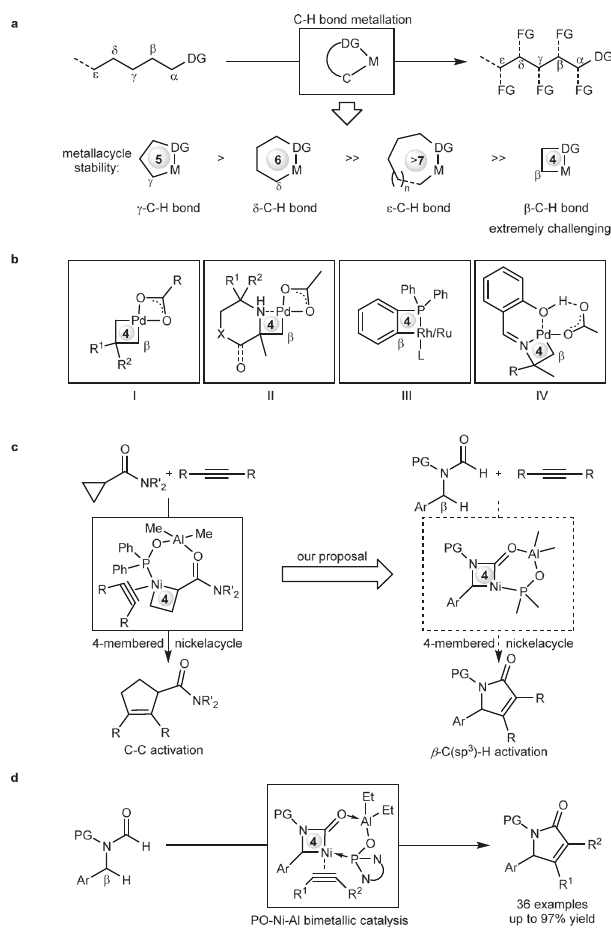
Fig. 1 | Transition metal-catalyzed C – H activation via cyclometallation. a The activationofC – Hbondsatdifferentpositiontothecoordinatingatomofdirecting groups is faced with varying levels of dif fi culty. γ -C – H bonds are the most easily activated via 5-membered metallacycles, while the activation of proximate β -C – H bonds via highly-strained 4-membered metallacycles is extremely challenging. b Only scarce examples on β -C – H bond activation via 4-membered metallacycles havebeenreported,andallofthemrelyonpreciousmetalssuchasPd,Rh,andRu. c Proposed secondary β -C(sp 3 ) – H bond activation: PO-ligated Ni – Al bimetal- catalyzedC – Hbondactivationvia4-memberednickelacycle. d 3d-Transitionmetal- catalyzed secondary C(sp 3 ) – H bond activation via 4-membered nickelacycle (this work). DGDirecting group. MMetal catalyst. FGFunctional group. PGProtecting